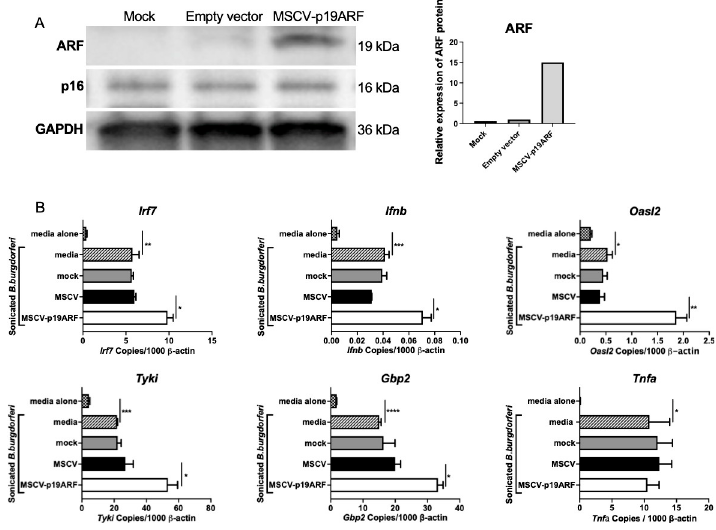
Fig 5. Overexpression of ARF in B6 macrophages enhances Ifnb expression. A) ARF was overexpressed in B6 BMDMs by transfection of the MSCV-p19ARF plasmid. The MSCV vector was transfected as the control. The transfected cells were allowed to rest for 72 h before the addition of sonicated B . burgdorferi for 6 h. The induction of IFN responses by B . burgdorferi treatment is confirmed by comparing the data from B . burgdorferi treated media with media alone. Total RNA and protein were isolated for analysis. B) The impact of ARF overexpression on activation of Ifnb and ISGs in response to sonicated B . burgdorferi stimulation in B6 BMDMs was determined by qPCR normalized to β -actin . Significance was calculated by Student t -test. Error bars indicate SEM (n = 3 per group). � p < 0.05, �� p <